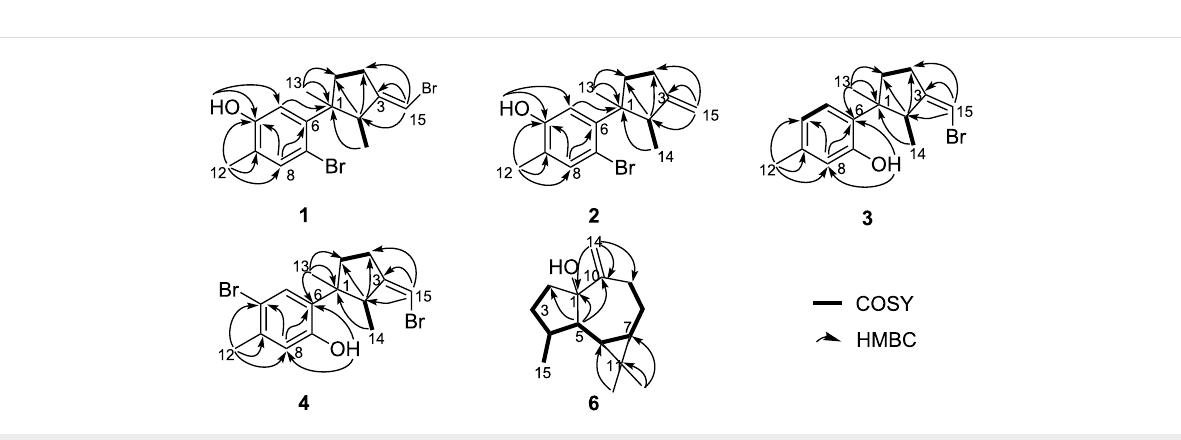
lecular ion peak at m/z 293.0548, [M − H] − (calcd for C 15 H 18 OBr 293.0541) in the HR-ESIMS spectrum. The 1 H